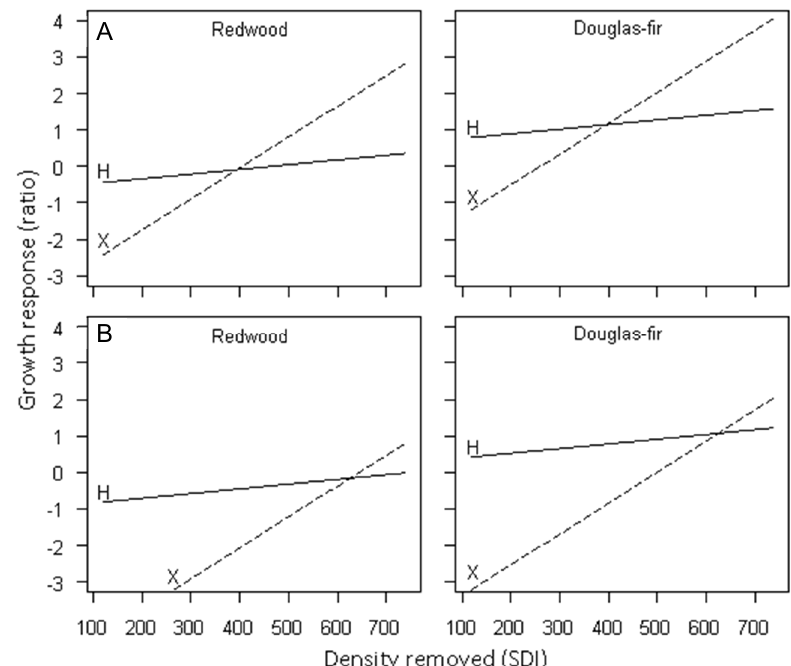
Figure 6. Redwood and Douglas ‐ fir branch growth response to SDI removed in herbicide (H) and harvest + herbicide (X) plot types in the first 5 ‐ year period ( A ) and second 5 ‐ year period ( B ) after treatment in Mendocino County, California.